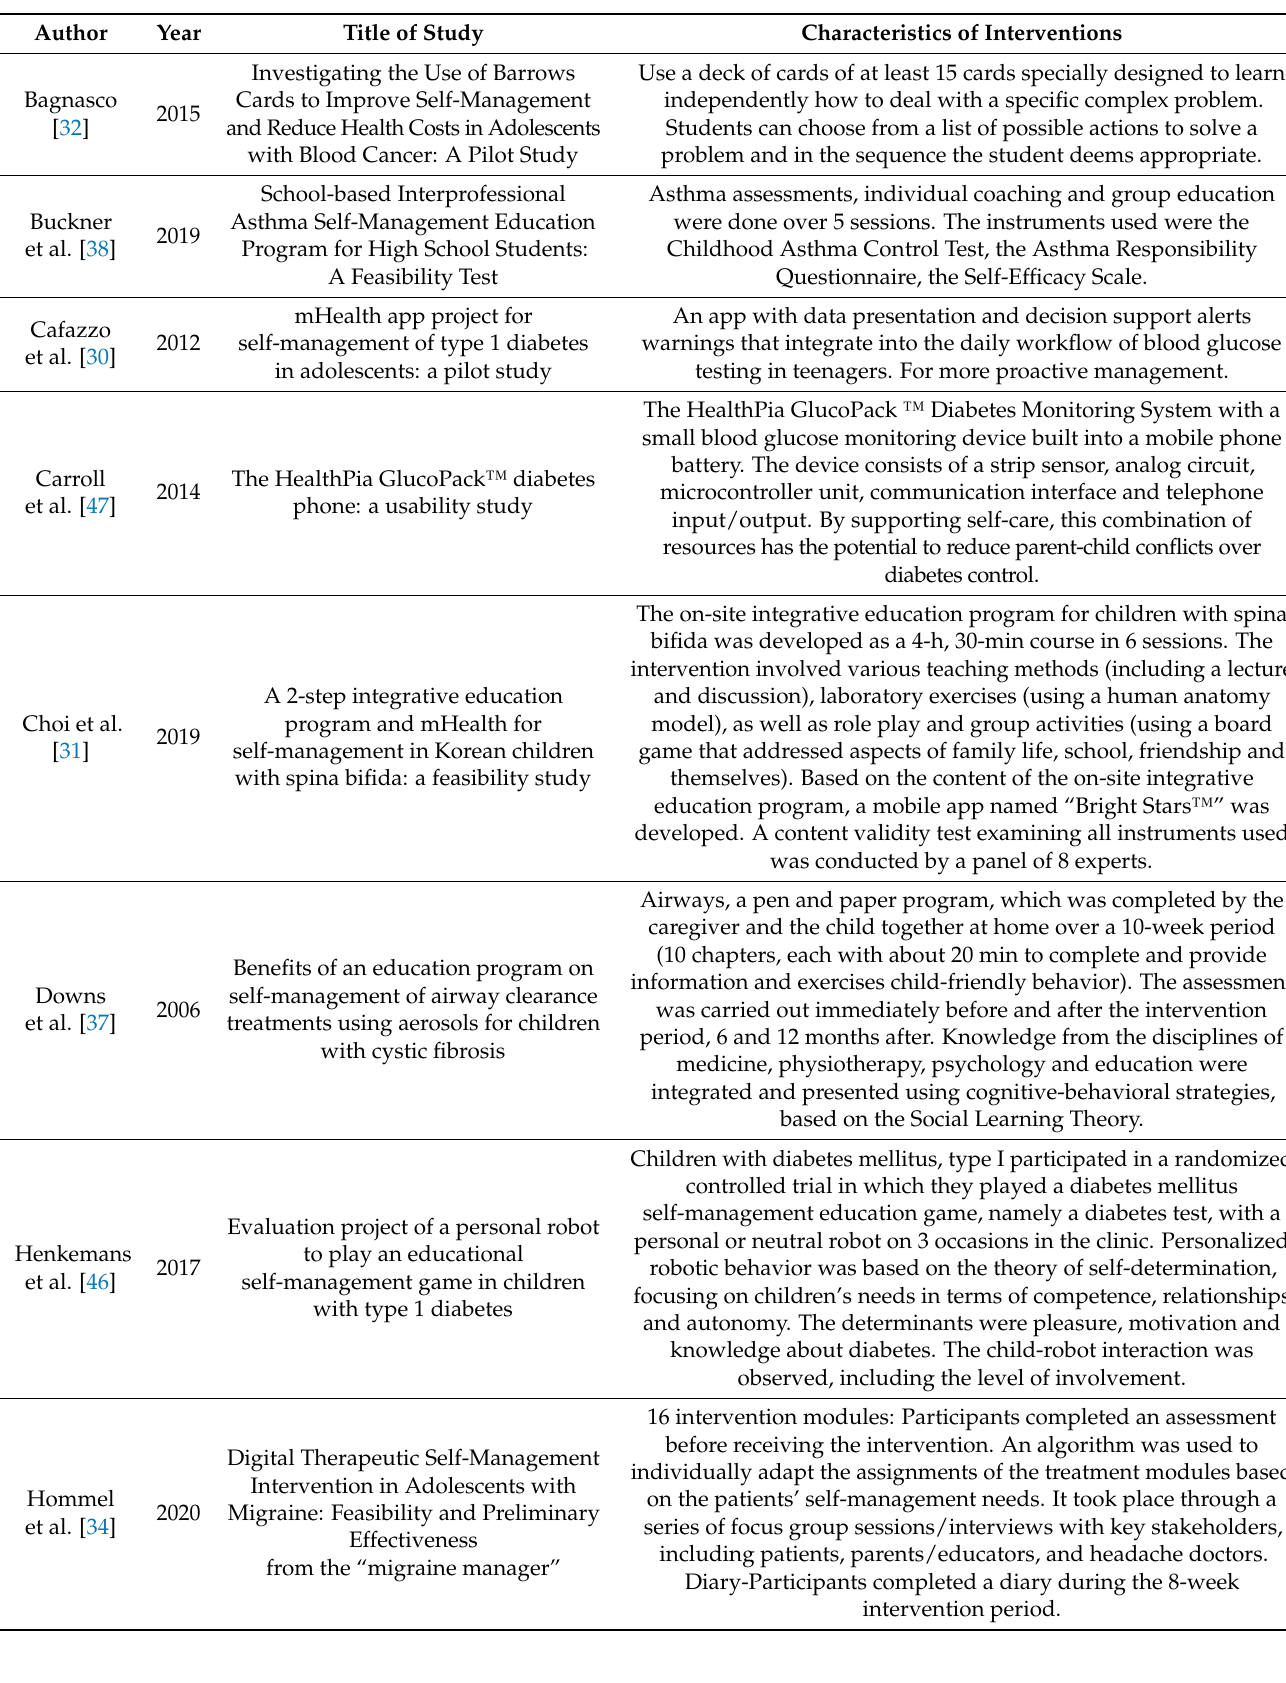
Table A6. Characteristics of interventions (unique and/or related activities, name, resources, frequency, duration, and